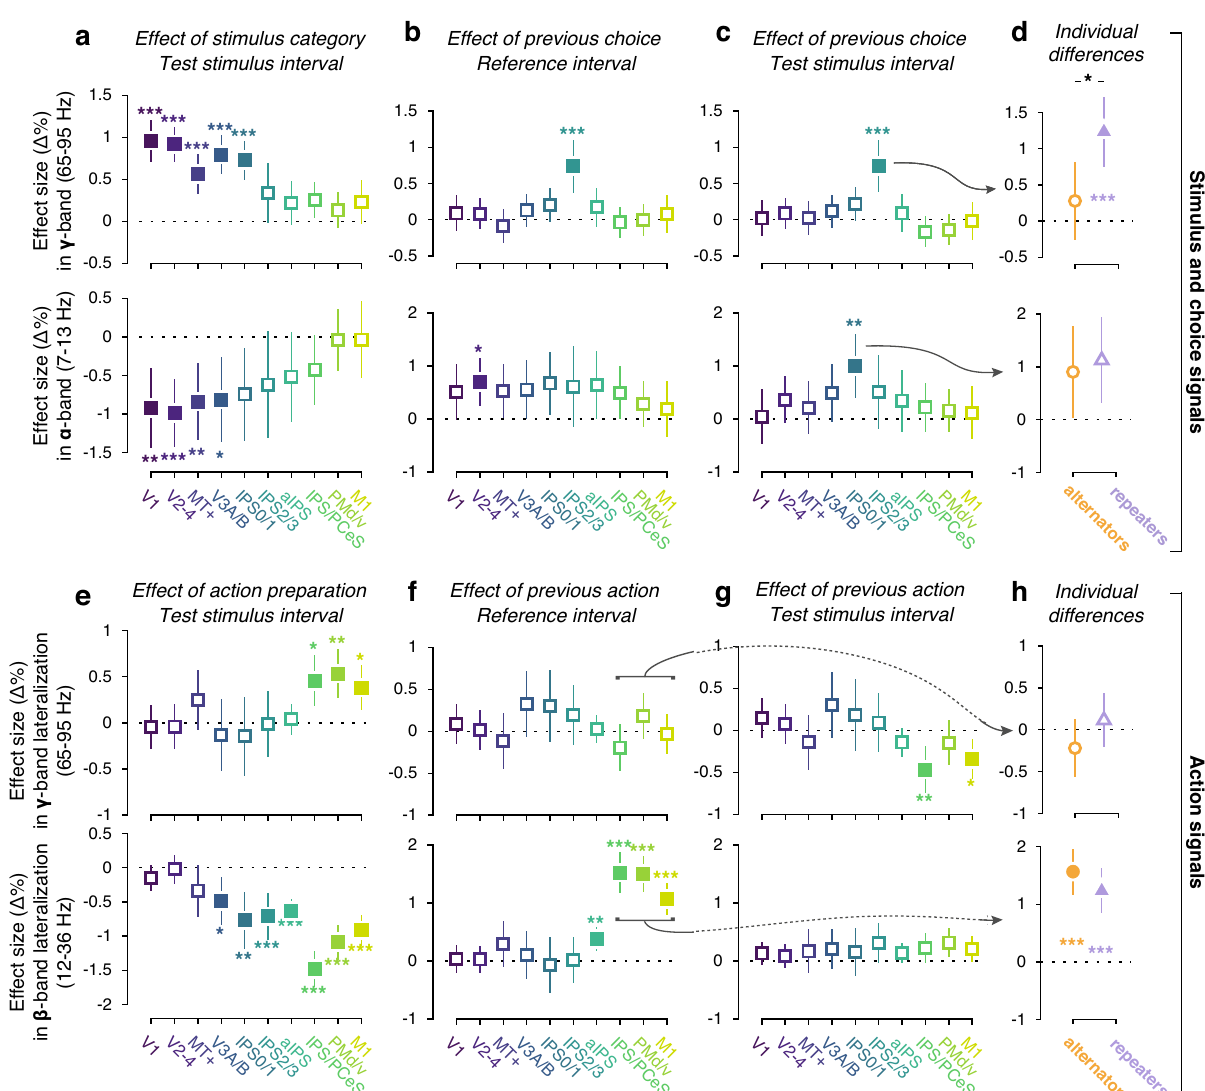
Fig.4|Task-relatedandchoicehistorysignalsacrosscorticalareas. Effectsizes from a general linear mixed model (see “ Methods ” ) estimating impact of stimulus category( a ),choice( b – d ),andaction( e – h )onMEGpower,indifferentregionsand frequency bands. a Effect of current stimulus category on gamma (top) and alpha (bottom) power during test stimulus ( n =60). b As a , but for effect of previous choiceinthereferenceinterval. c As b ,butforteststimulusinterval. d Comparison ofchoicehistorysignalsbetweenalternators( n =25;orange)andrepeaters( n =34; purple). Group effect=0.55328, CI [0.19342, 0.91314], p =0.00258. e Effect of